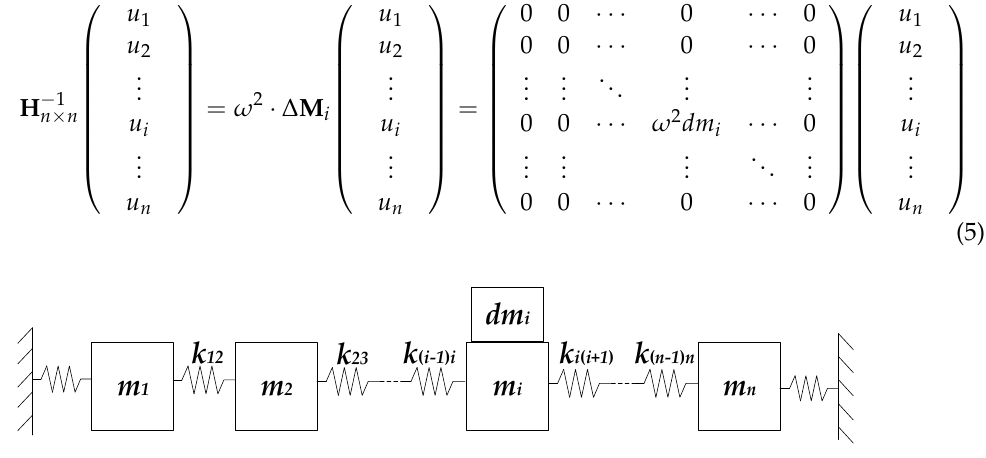
Figure 2. Structural modification by adding mass.